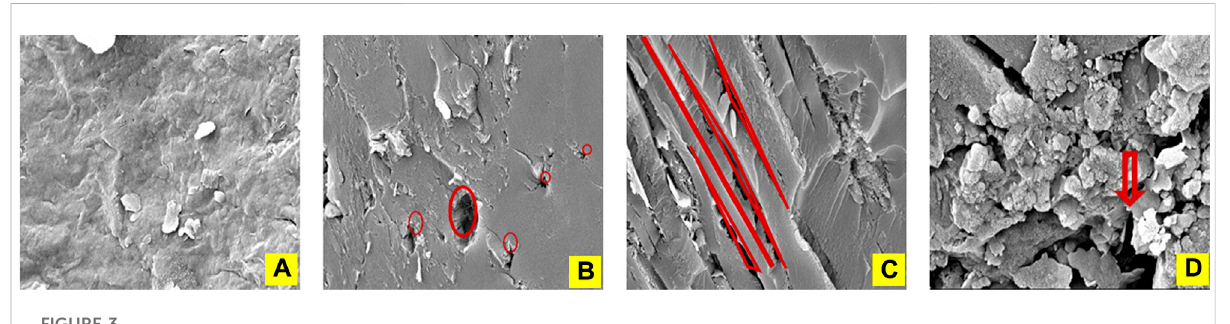
FIGURE 3 Types of coal pores at the test